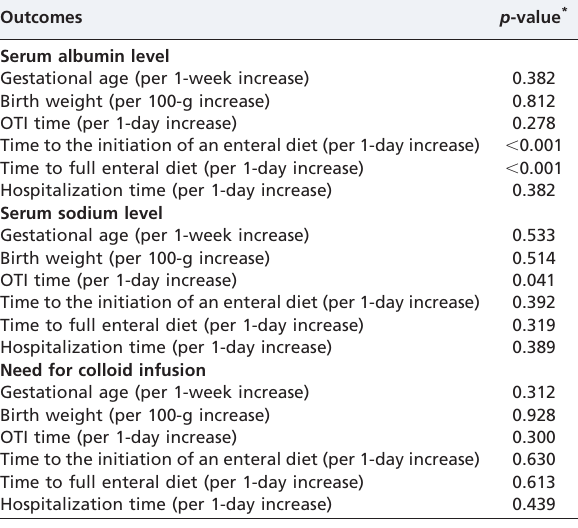
Table 3 - Results of the multiple linear regression analysis evaluating the association between independent variables and patient outcomes.